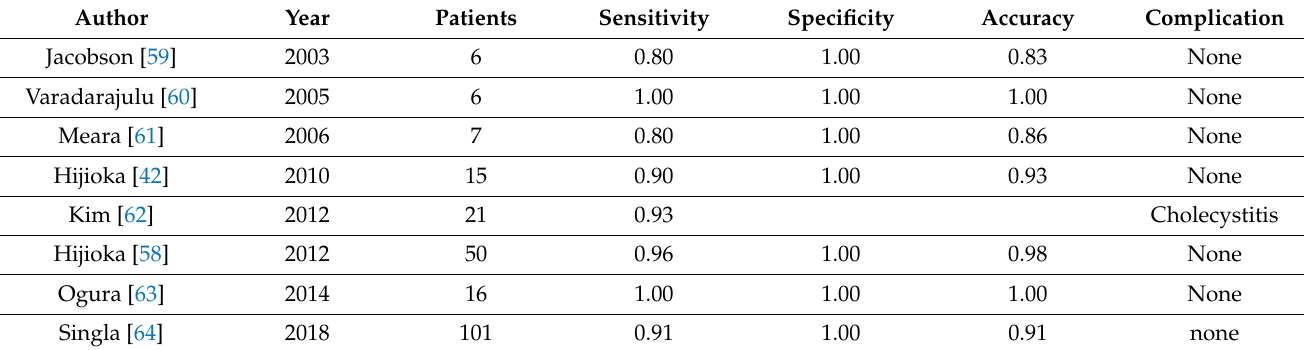
Table 7. The results on EUS-FNA for the diagnosis of GB